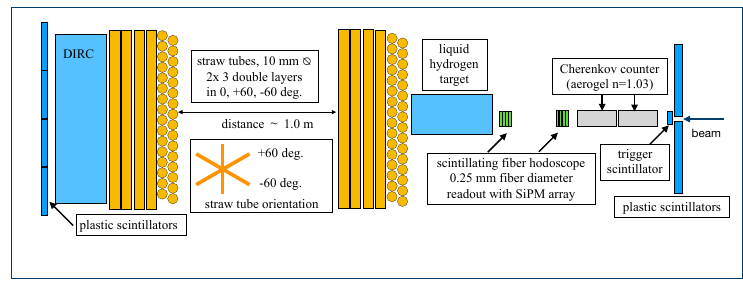
Figure 2. Sketch of the detection system for the follow-up